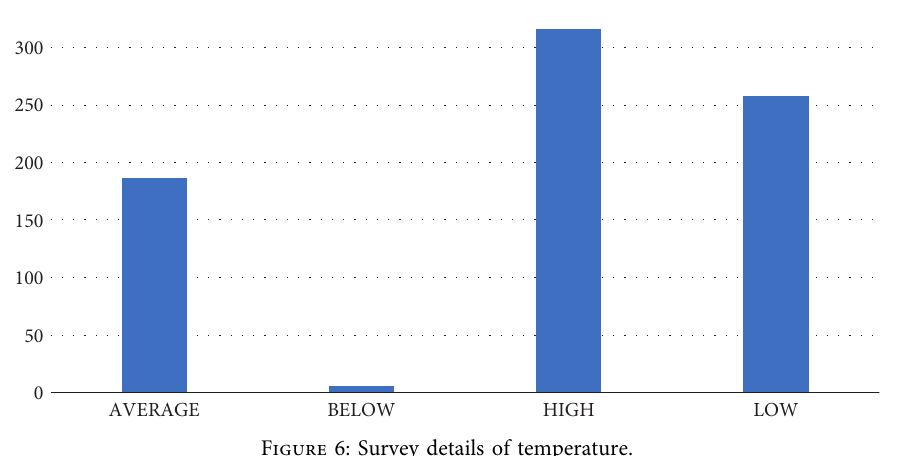
Figure 6: Survey details of temperature.